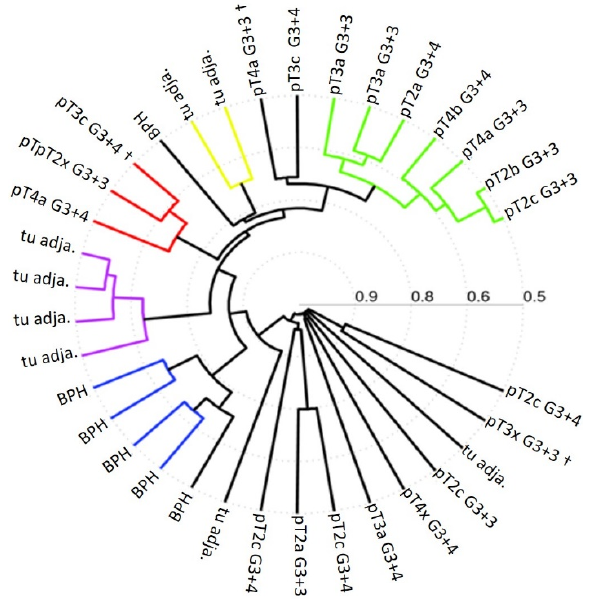
grade of methylation is also indicated by numbers within the colored rectangles. A higher number corresponds to higher methylation.